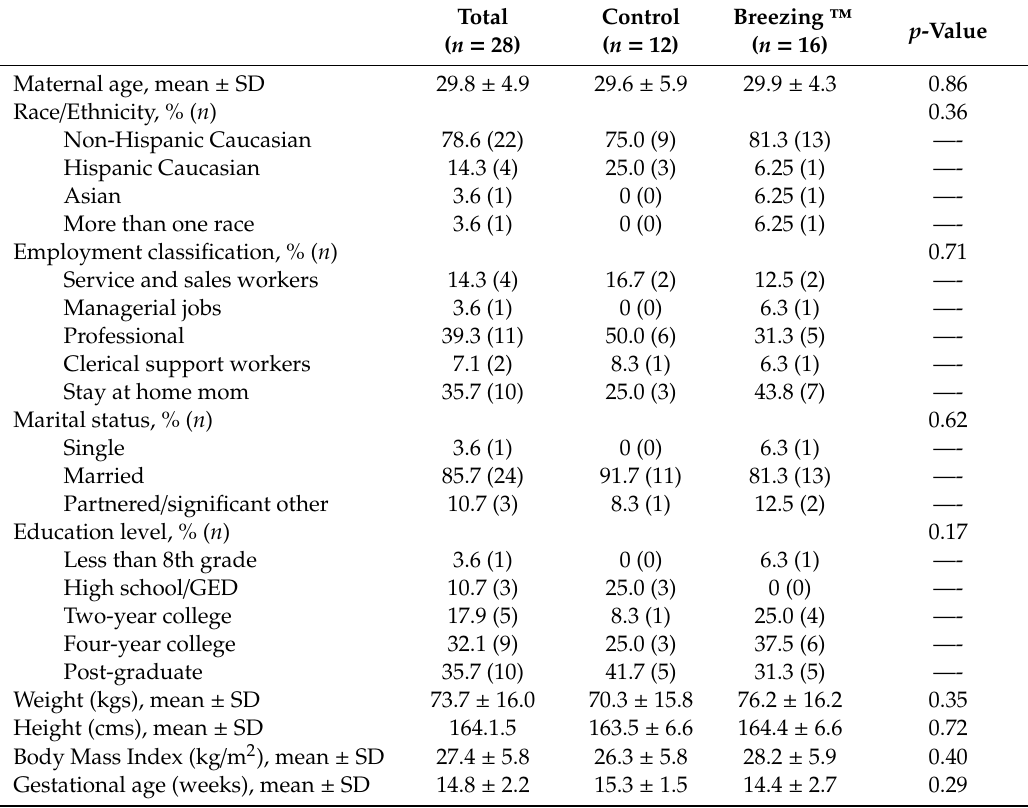
Table 1. Participant Demographics and Baseline Anthropometrics, Behavioral, and Prenatal